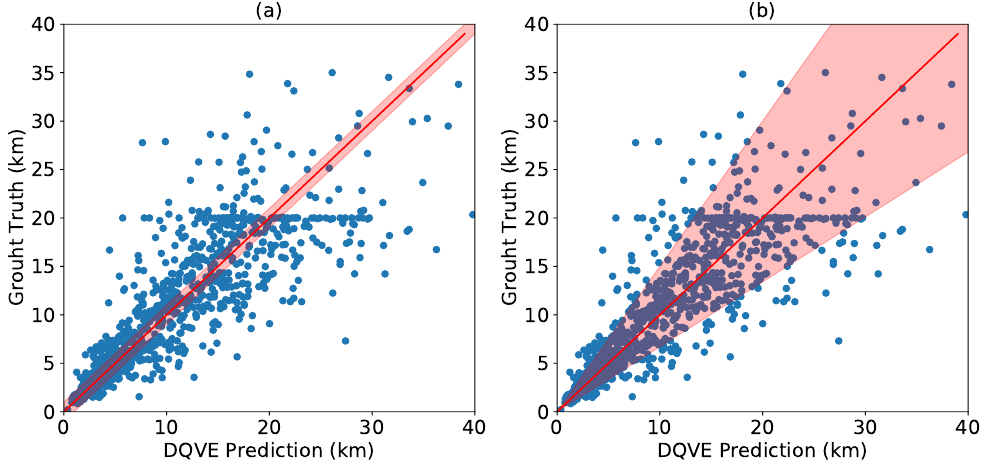
Figure 6. Correlation analysis of the proposed DQVENet; ( a ) hard gap. ( b ) soft